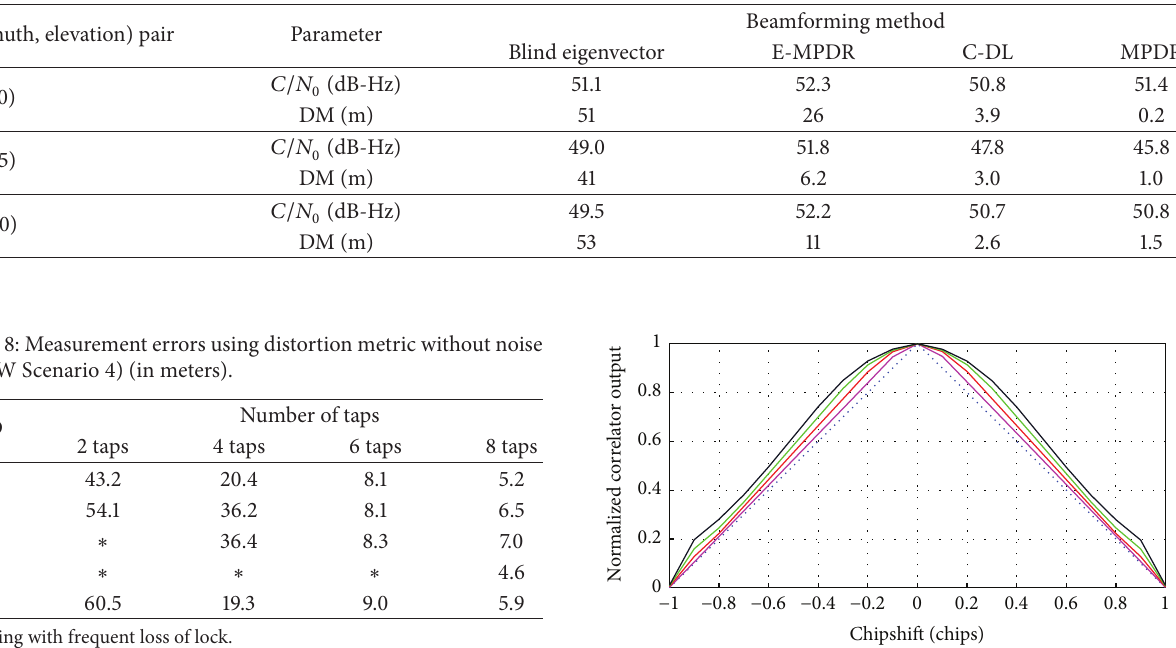
Table 7: Changing interference placement: comparison of different beamformers.